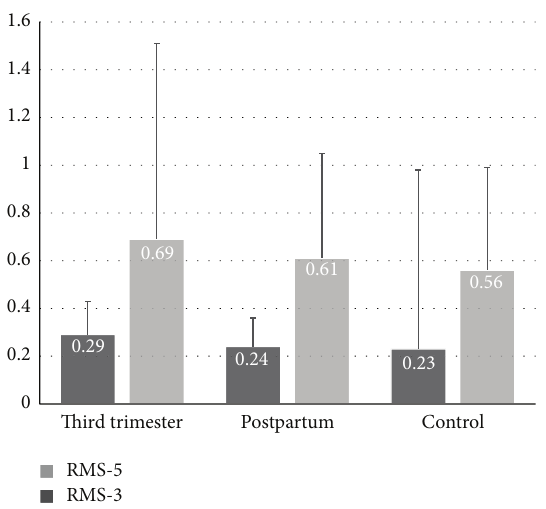
Figure 2: Bar graphics showing comparison of root mean square at 3 mm (RMS-3) and root mean square at 5 mm (RMS-5) values of pregnantwomenatthethirdtrimesterandatthesecondpostpartum month to nonpregnant control group of women. Error bars show + standard deviations